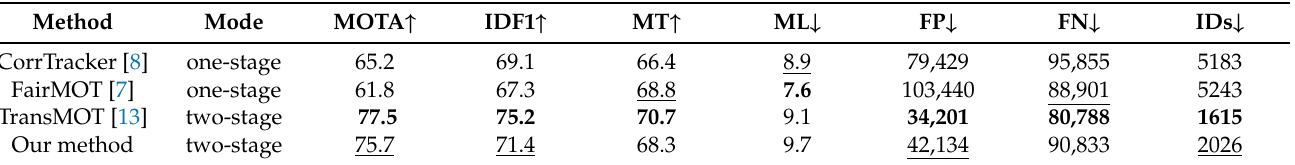
Table 2. Comparison with the state-of-the-art methods over the dataset MOT20 test set. The best results are shown in bold . The next best result is